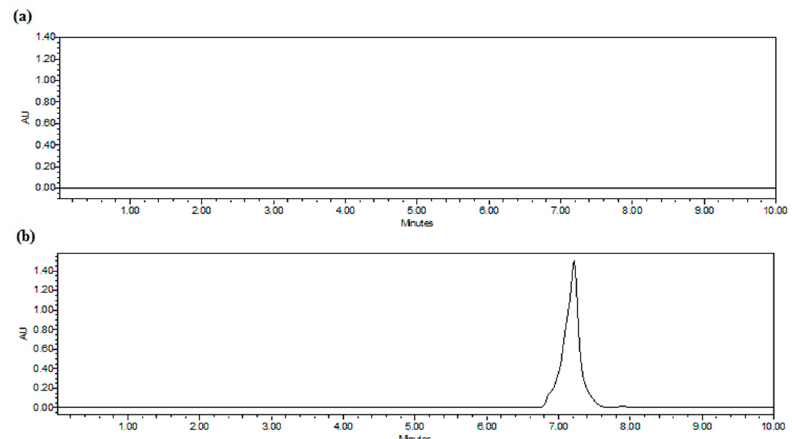
Figure 3. Retention time recorded in the chromatogram of the ( a ) filtrated drug-free SLN formulation (F1) ( b ) and in the chromatogram of trans -resveratrol (tRES) standard solution (50.0 µg/mL).